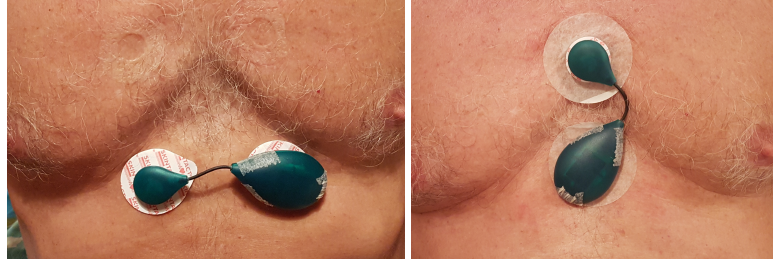
Figure 6. ECG sensors fixed with self-adhesive electrodes in two often used positions: horizontal ( left ) and vertical ( right